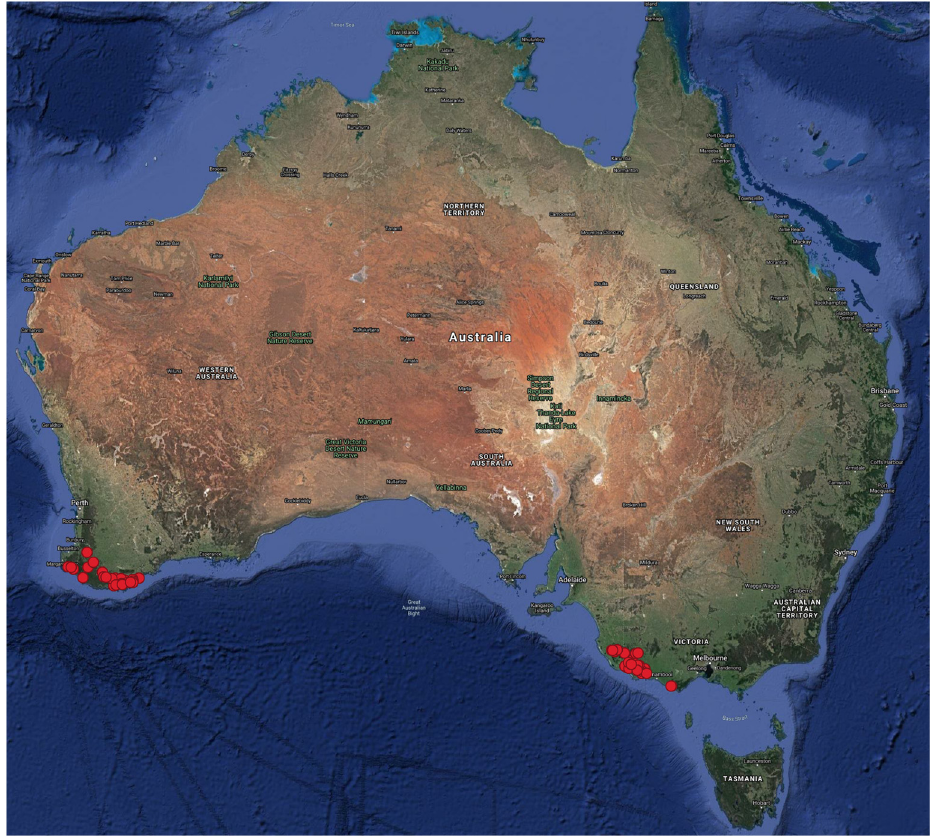
Figure 9. A map showing plot locations. The left cluster includes plots 1 to 27 in Western Australia, and the right cluster includes plots 28 to 49. Satellite map sourced from Google Earth [63].